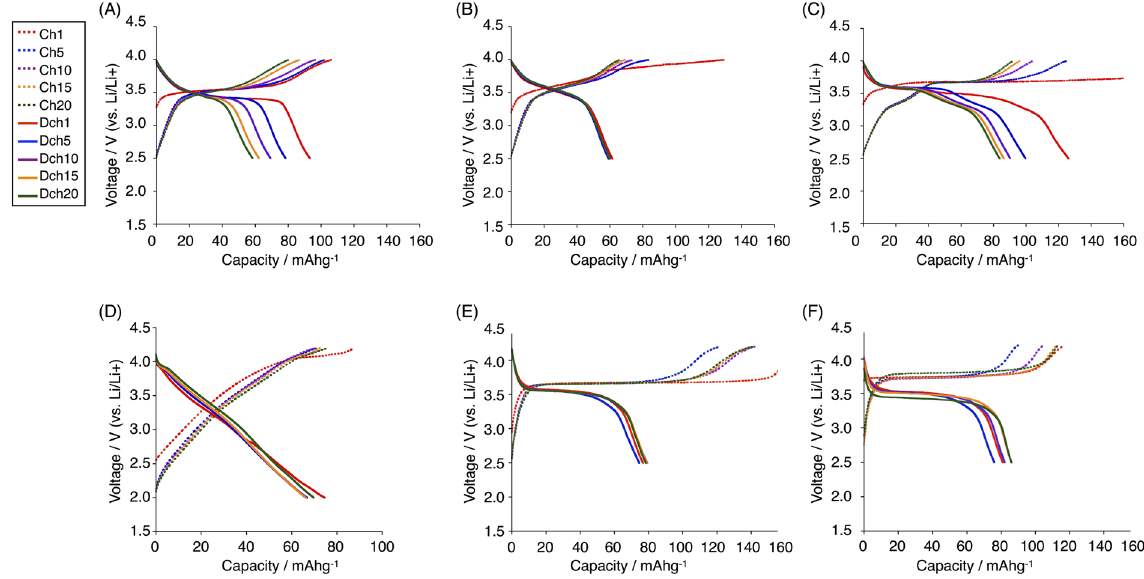
Figure 6. Selected charge/discharge curves of fabricated batteries using ( A ) 1b (rate = 10.4 mAg − 1 ), ( B ) 2b (rate = 14.9 mAg − 1 ), ( C ) 3b (rate = 19.2 mAg − 1 ), ( D ) 4 (rate = 57.3 mAg − 1 ) by method A and those using ( E ) 3b (rate = 200 mAg − 1 ), ( F ) 3b (rate = 500 mAg − 1 ) by method B. The potential is shown vs. Li/Li + and the capacity is normalized by the weight of the compounds.